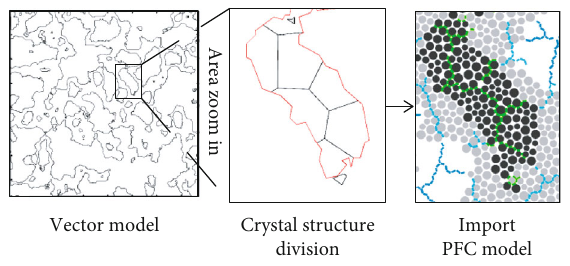
Figure 4: GBM-Voronoi crystal structure construction process.